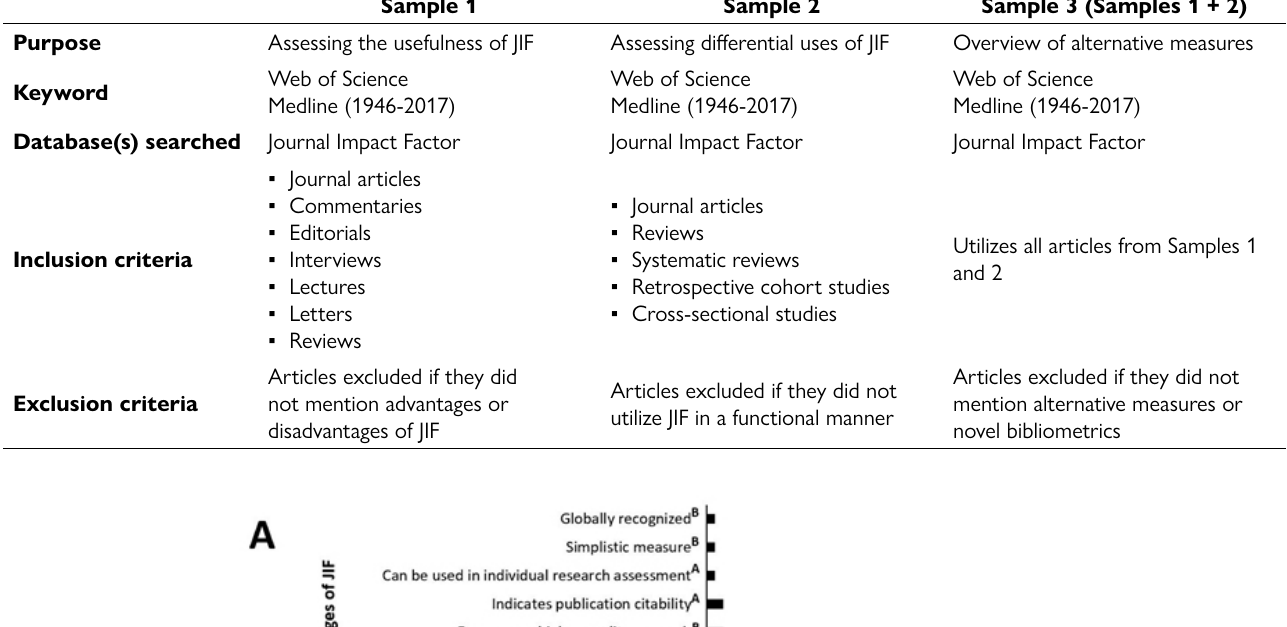
Table 1. Search strategy summary.